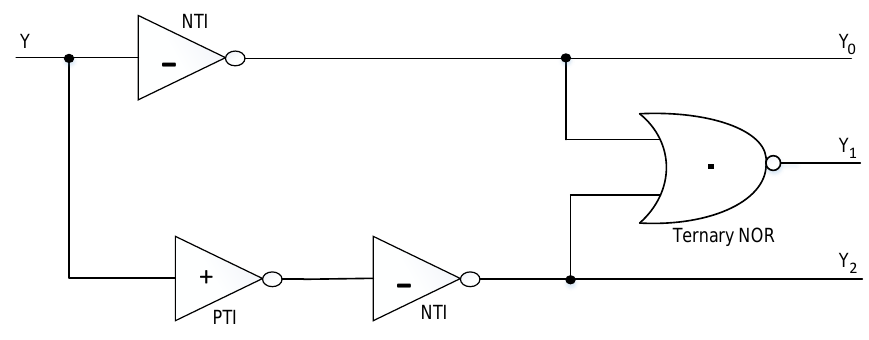
Figure 3. Schematic of ternary decoder [11]. The TG block logic schematic is shown in Figure 4. The TG block comprises the number of transmission gates which connect the inputs X 0 X 1 and Y 0 Y 1 to various arithmetic and logical modules to perform the desired operation. The parallel connection of PCNTFET and NCNTFET is used for the implementation of the transmission